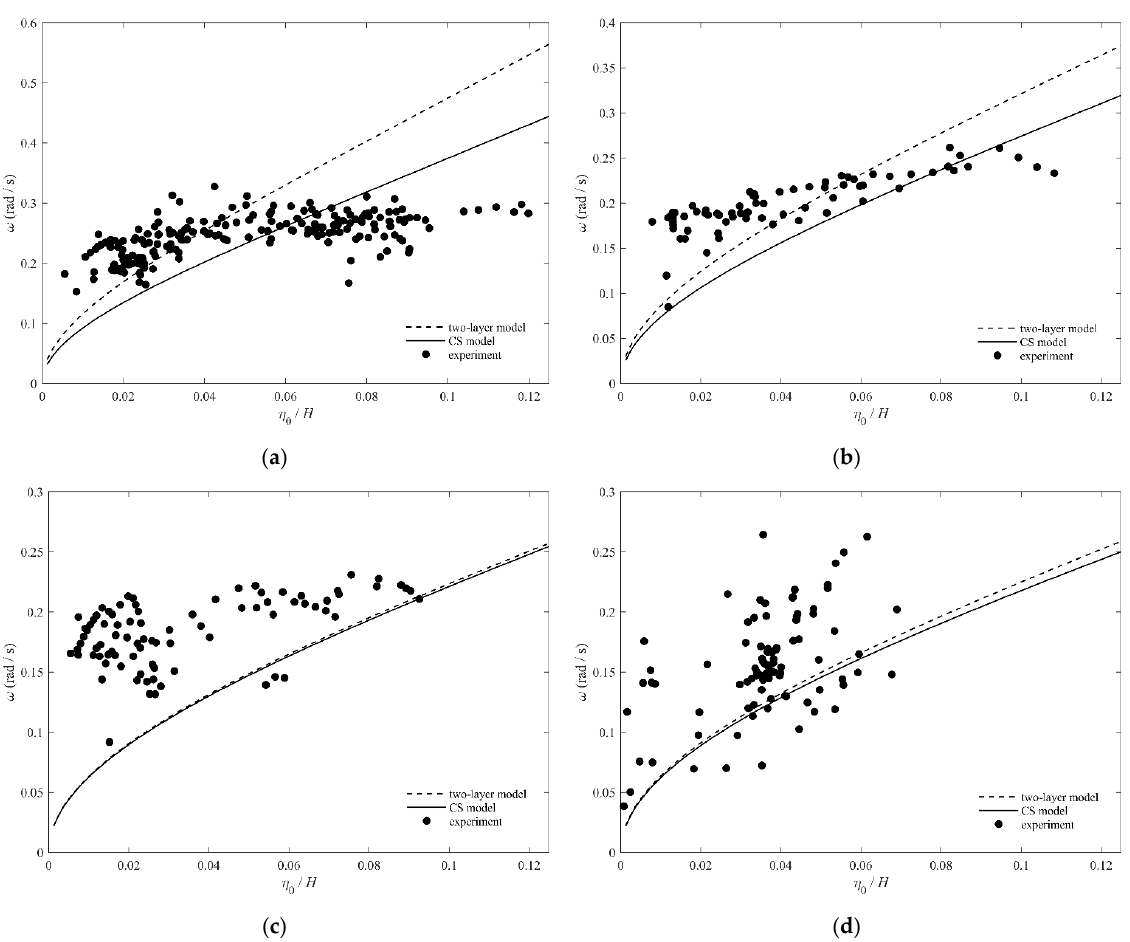
Figure 7. Experimental and theoretical frequency–amplitude relationship of ISWs: ( a ) S1; ( b ) S2; ( c ) S3; ( d ) S4.